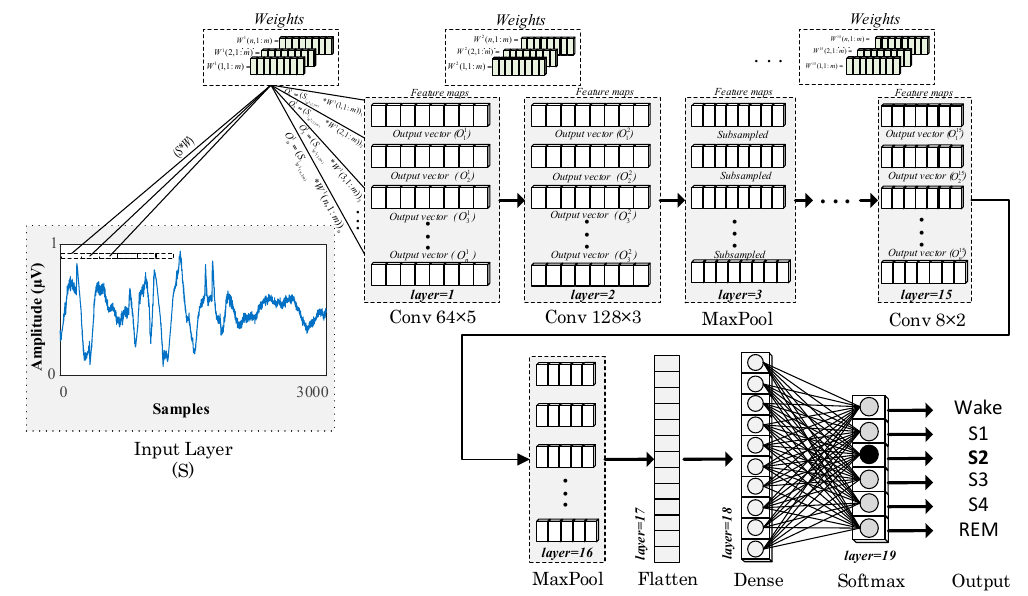
Figure 2. Block representation of the proposed one-dimensional convolutional neural network